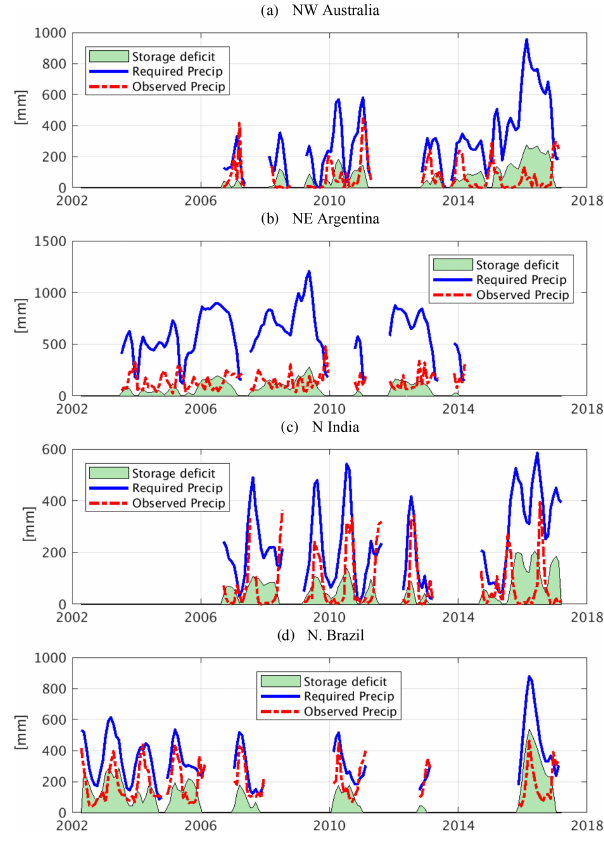
Figure 6. Validation of the required precipitation estimate by drought recovery estimates at example locations. The different in- stances of drought show that drought ends (from the perspective of TWSA) whenever the observed precipitation (red plot) exceeds the required precipitation (blue